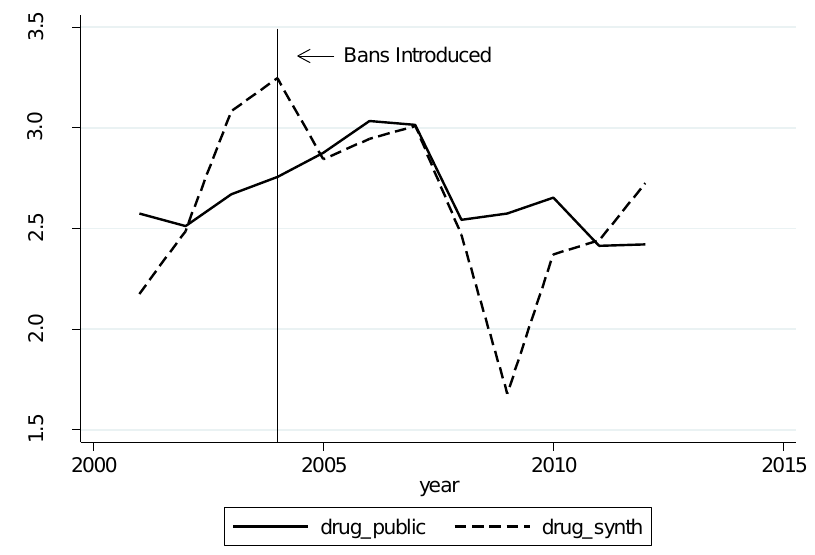
Figure A4. Trends in drug arrests: public housing vs. synthetic public housing.